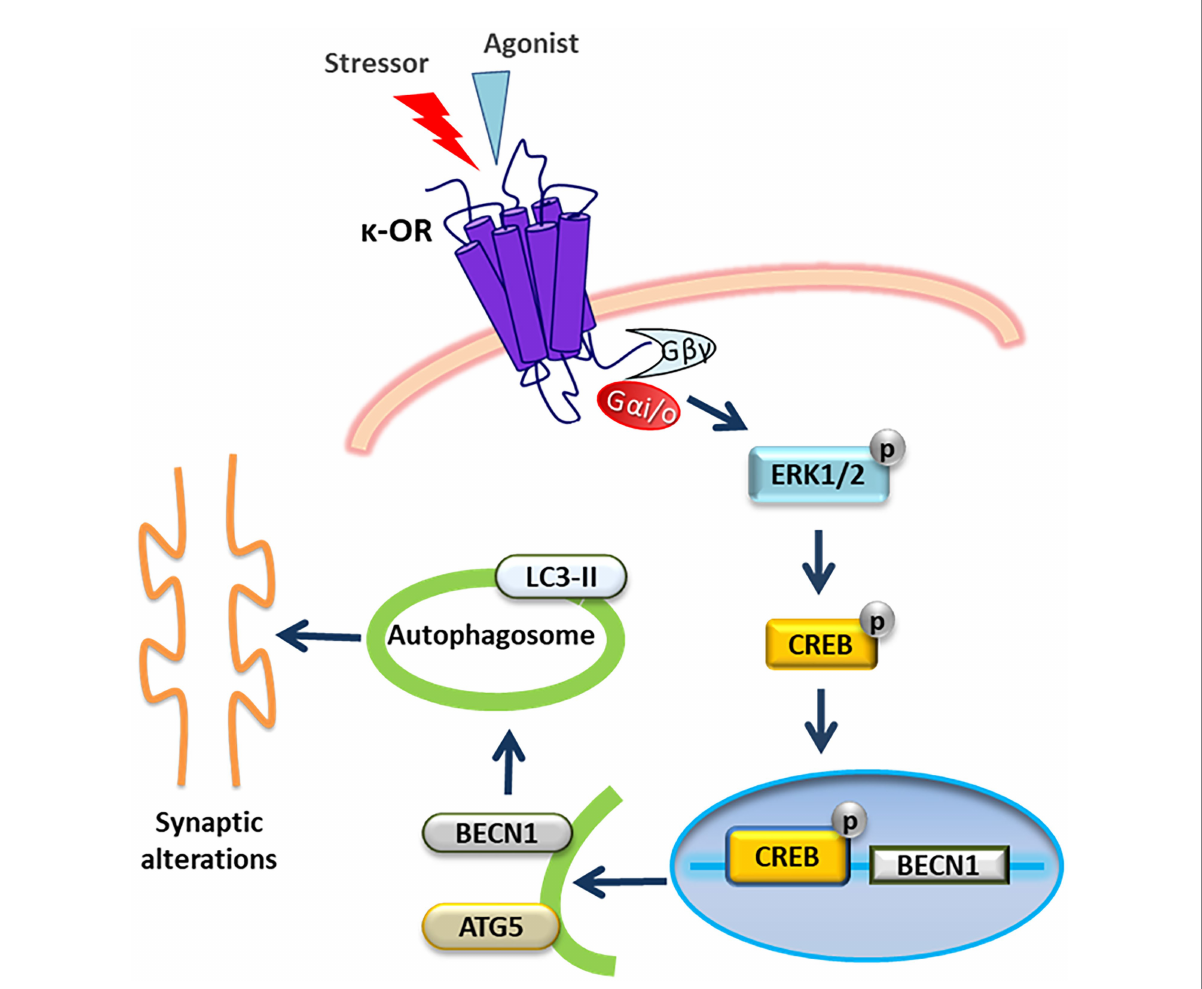
FIGURE 8 Schematic representation of a putative signaling pathway via which κ -OR activation triggers autophagy resulting in synaptic alterations. Activation of κ - Ο R in neuronal cells leads to ERK1,2 phosphorylation mediated by Gi/ ο proteins. Α ctivated ERK1,2 subsequently phosphorylates CREB which in turn translocates to the nucleus to activate Becn1 gene expression. Upregulation of Beclin1 and Atg5 promotes the initiation of autophagy resulting in alterations of hippocampal synaptic proteins enriched in dendritic